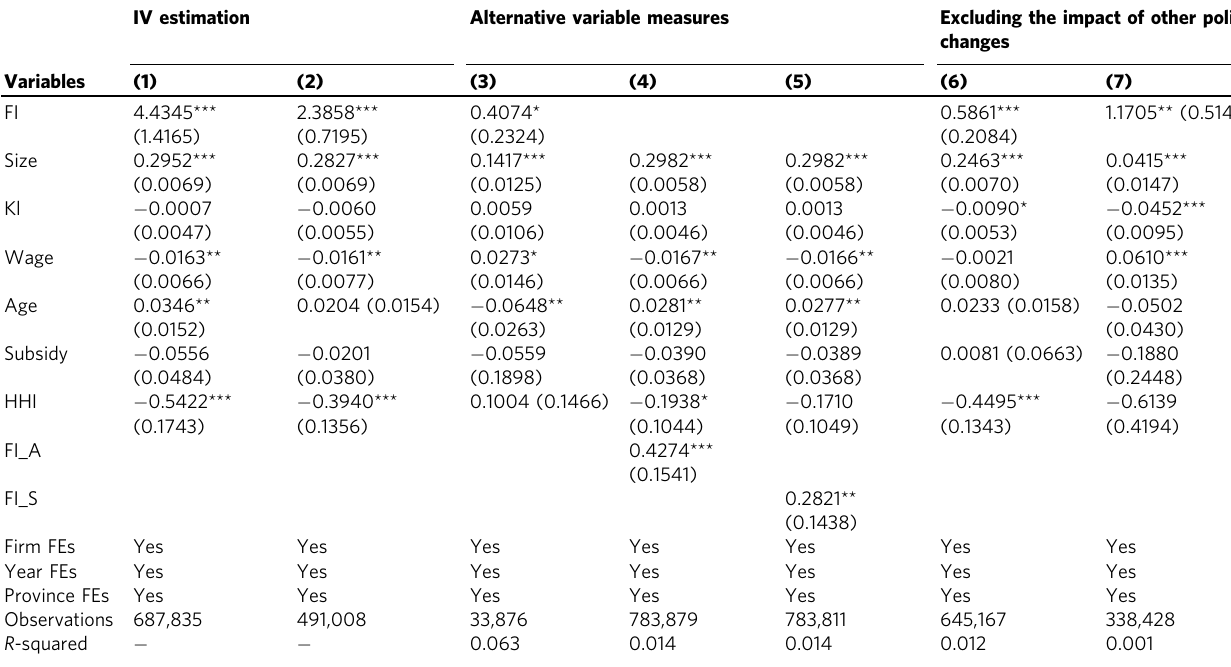
Table 3 Robustness test